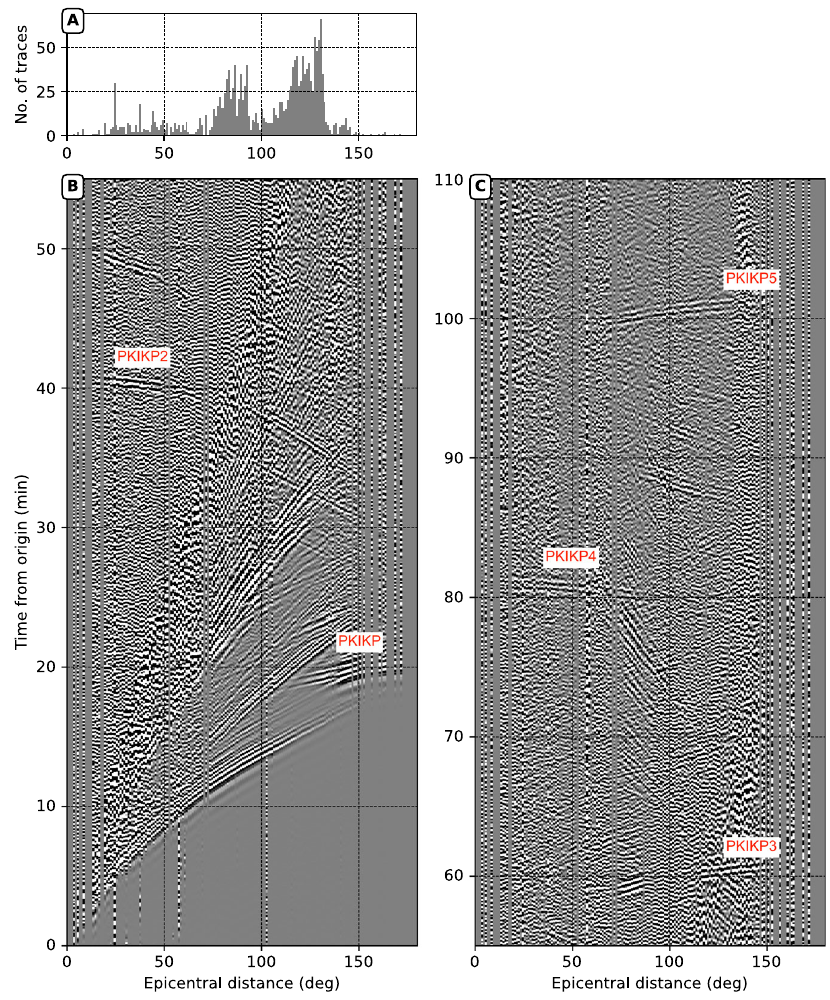
Fig. 2 | Global stack for the 22 Jan 2017, Mw=7.9 Solomon Islands earthquake. A Histogram of seismic waveforms as a function of epicentral distance in 1-degree bins. B and C Global stacks spanning 0 – 55min and 55 – 110min. Exotic podal and